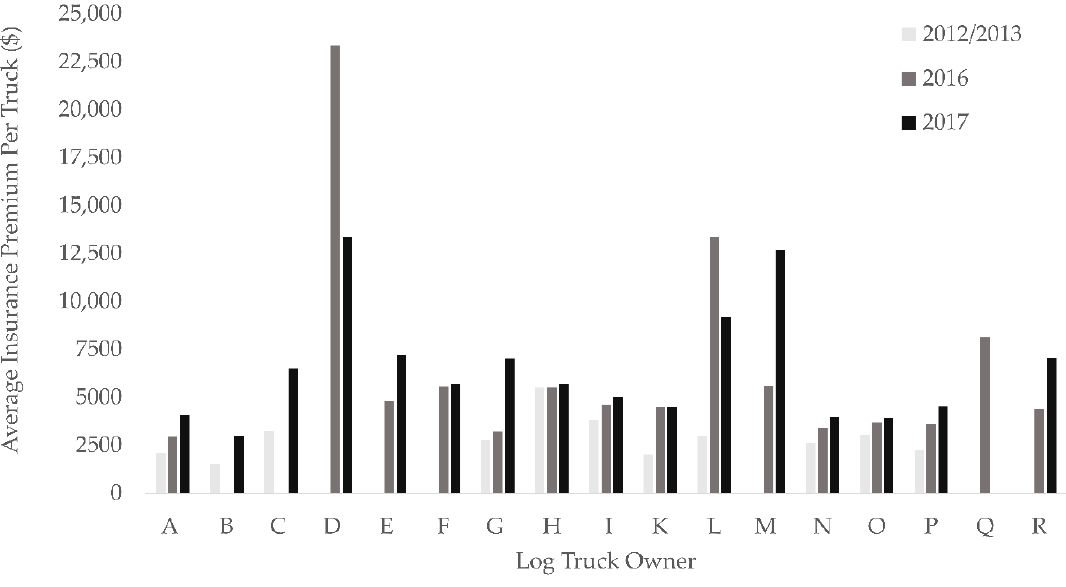
Figure 2. Average annual per-truck insurance premiums for the interviewed log truck owners in 2012/2013, 2016, and 2017. The values provided are for the entire cost of insurance, including both liability and other types of insurance. Not all truck owners provided data for each period of interest.